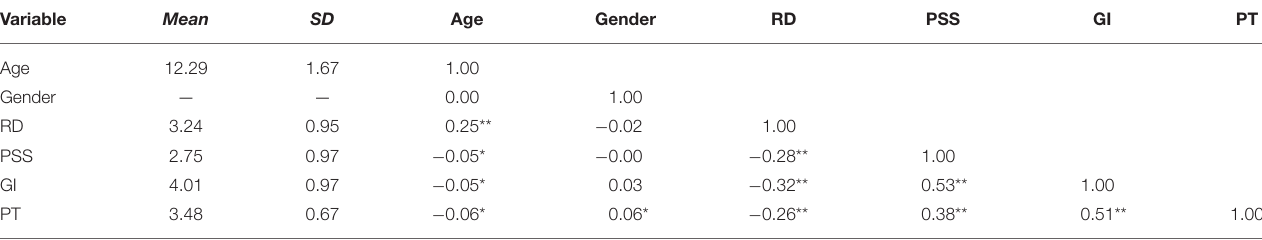
TABLE 1 | Descriptive statistics and correlations among core variables.